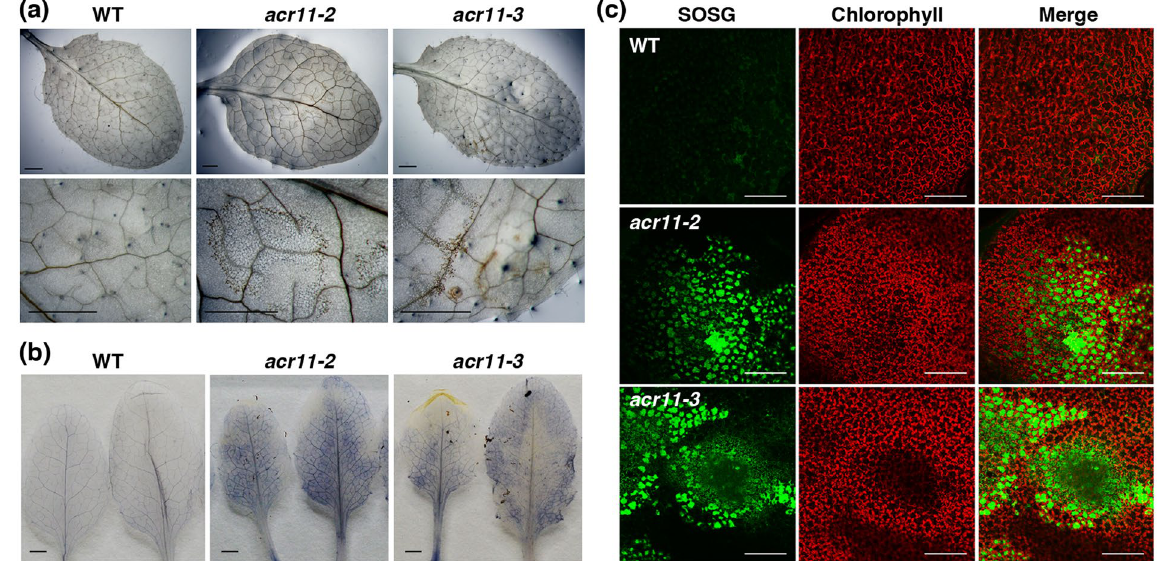
Figure 3. Comparison of reactive oxygen species levels in the rosette leaves of 5-week-old Arabidopsis wild- type (WT) and acr11 mutant plants. ( a ) Staining of hydrogen peroxide by 3,3 ′ -diaminobenzidine. ( b ) Staining of superoxide radical by nitroblue tetrazolium. ( c ) Staining of singlet oxygen species by Singlet Oxygen Sensor Green (SOSG) fluorescent dye. Scale bars are 1 mm in ( a ) and ( b ), 200 μ m in ( c ).